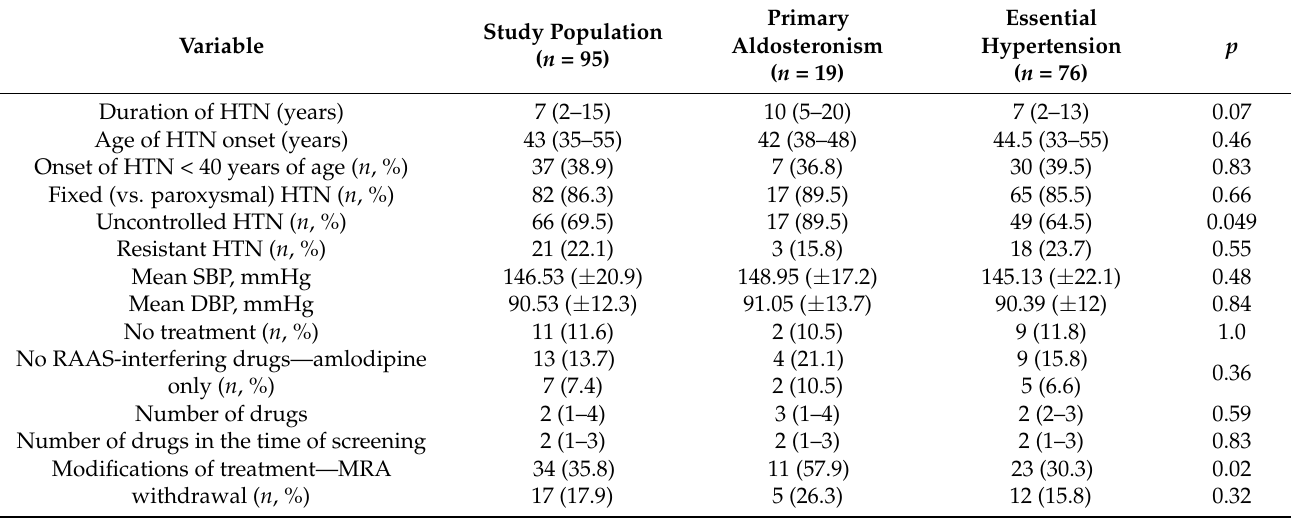
Clinical characteristics of the study cohort, excluding participants with